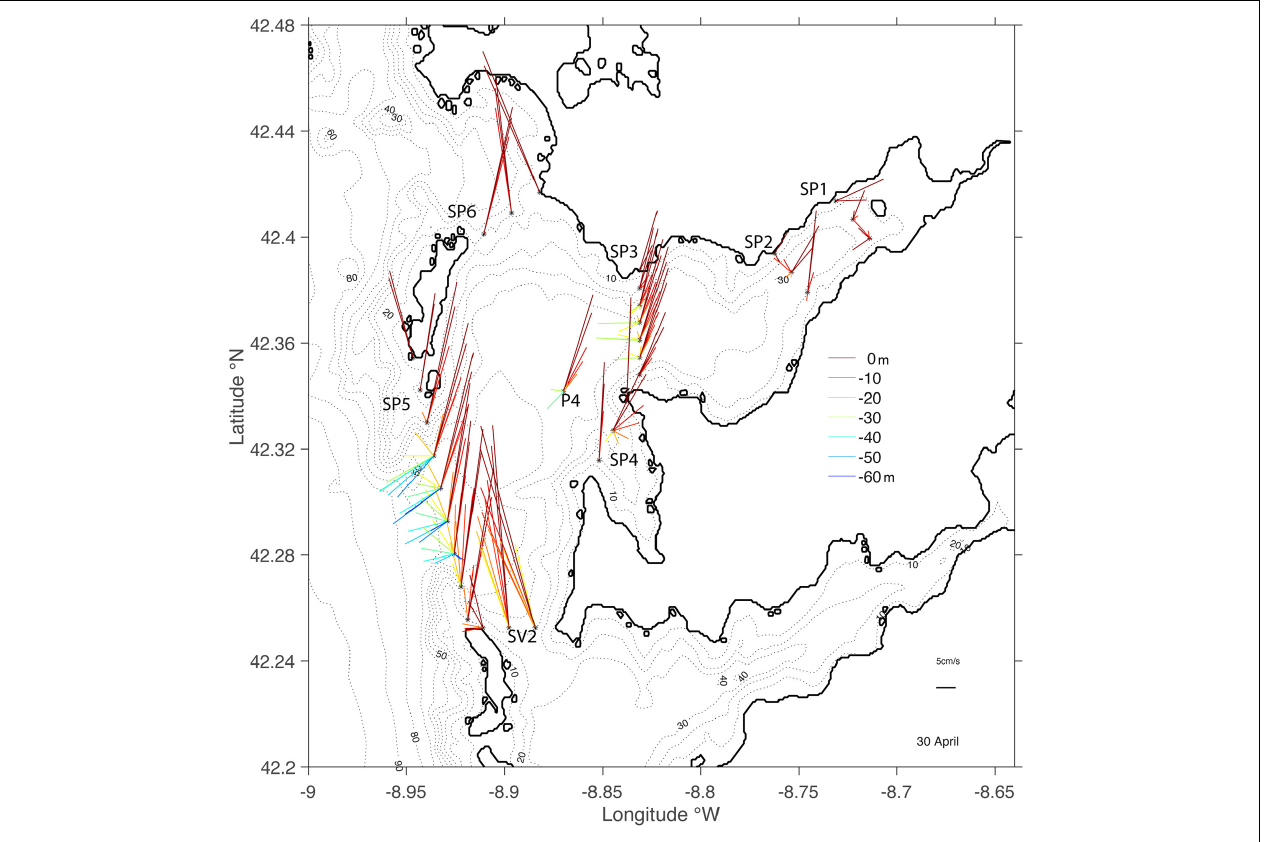
FIGURE 7 | Same as Figure 5 for day 30 April.